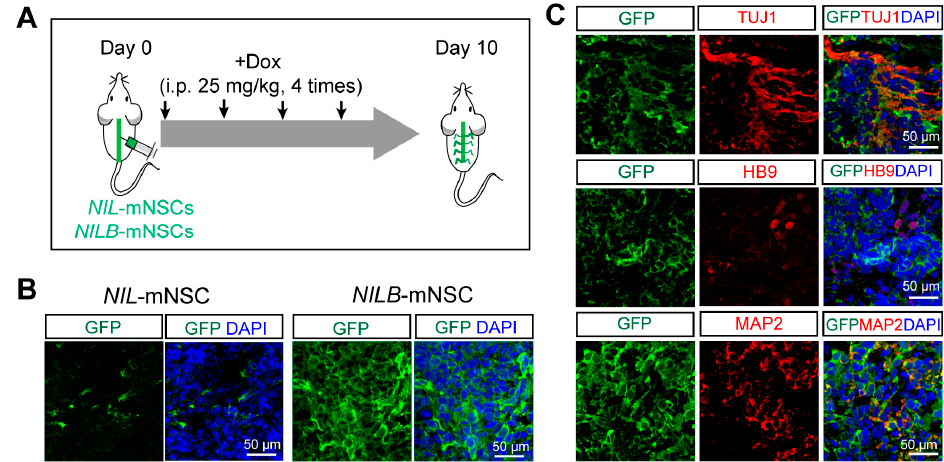
Figure 5. Differentiation of NILB − mNSCs after transplantation in SOD − G93A mice. ( A ) Flow diagram of NIL − mNSCs and NILB − mNSCs transplantation and detection. ( B ) Immunostaining for GFP-positive cells after NIL − mNSCs and NILB − mNSCs transplantation for 10 days. ( C ) Immunostaining for neuronal markers TUJ1, HB9 and MAP2 in the spinal cords of NILB − mNSCs − transplanted animals, bar = 50 μ m.